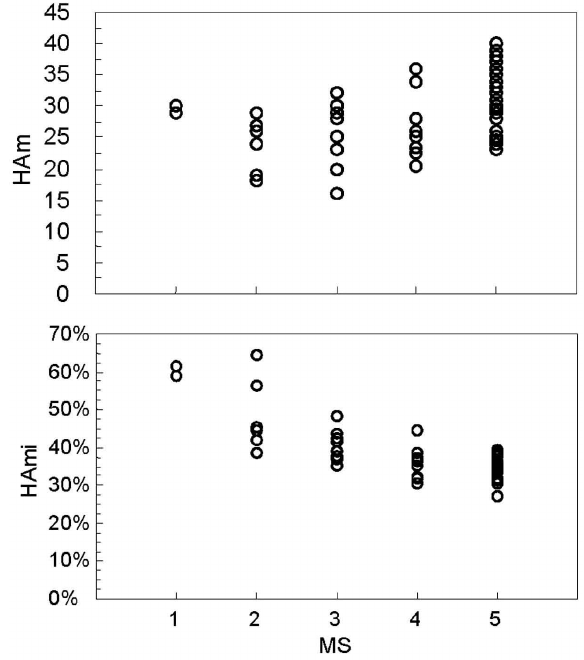
F ig . 7. – Plots of HAm and HAmi vs maturity stage